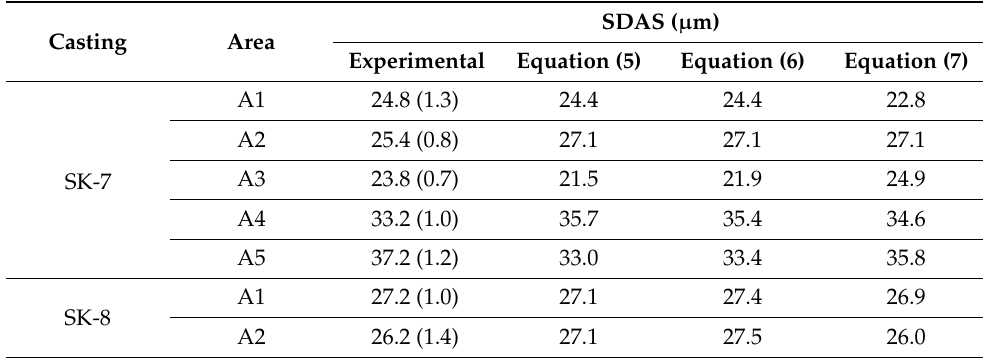
Table 8. Experimental and calculated SDAS values in the areas of castings SK-7 and SK-8 (standard deviation values are shown between